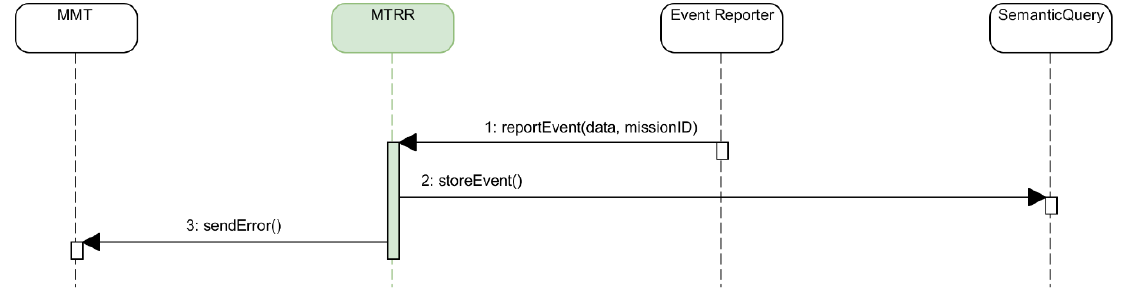
Figure 20. Sequence diagram for the management of an event report.